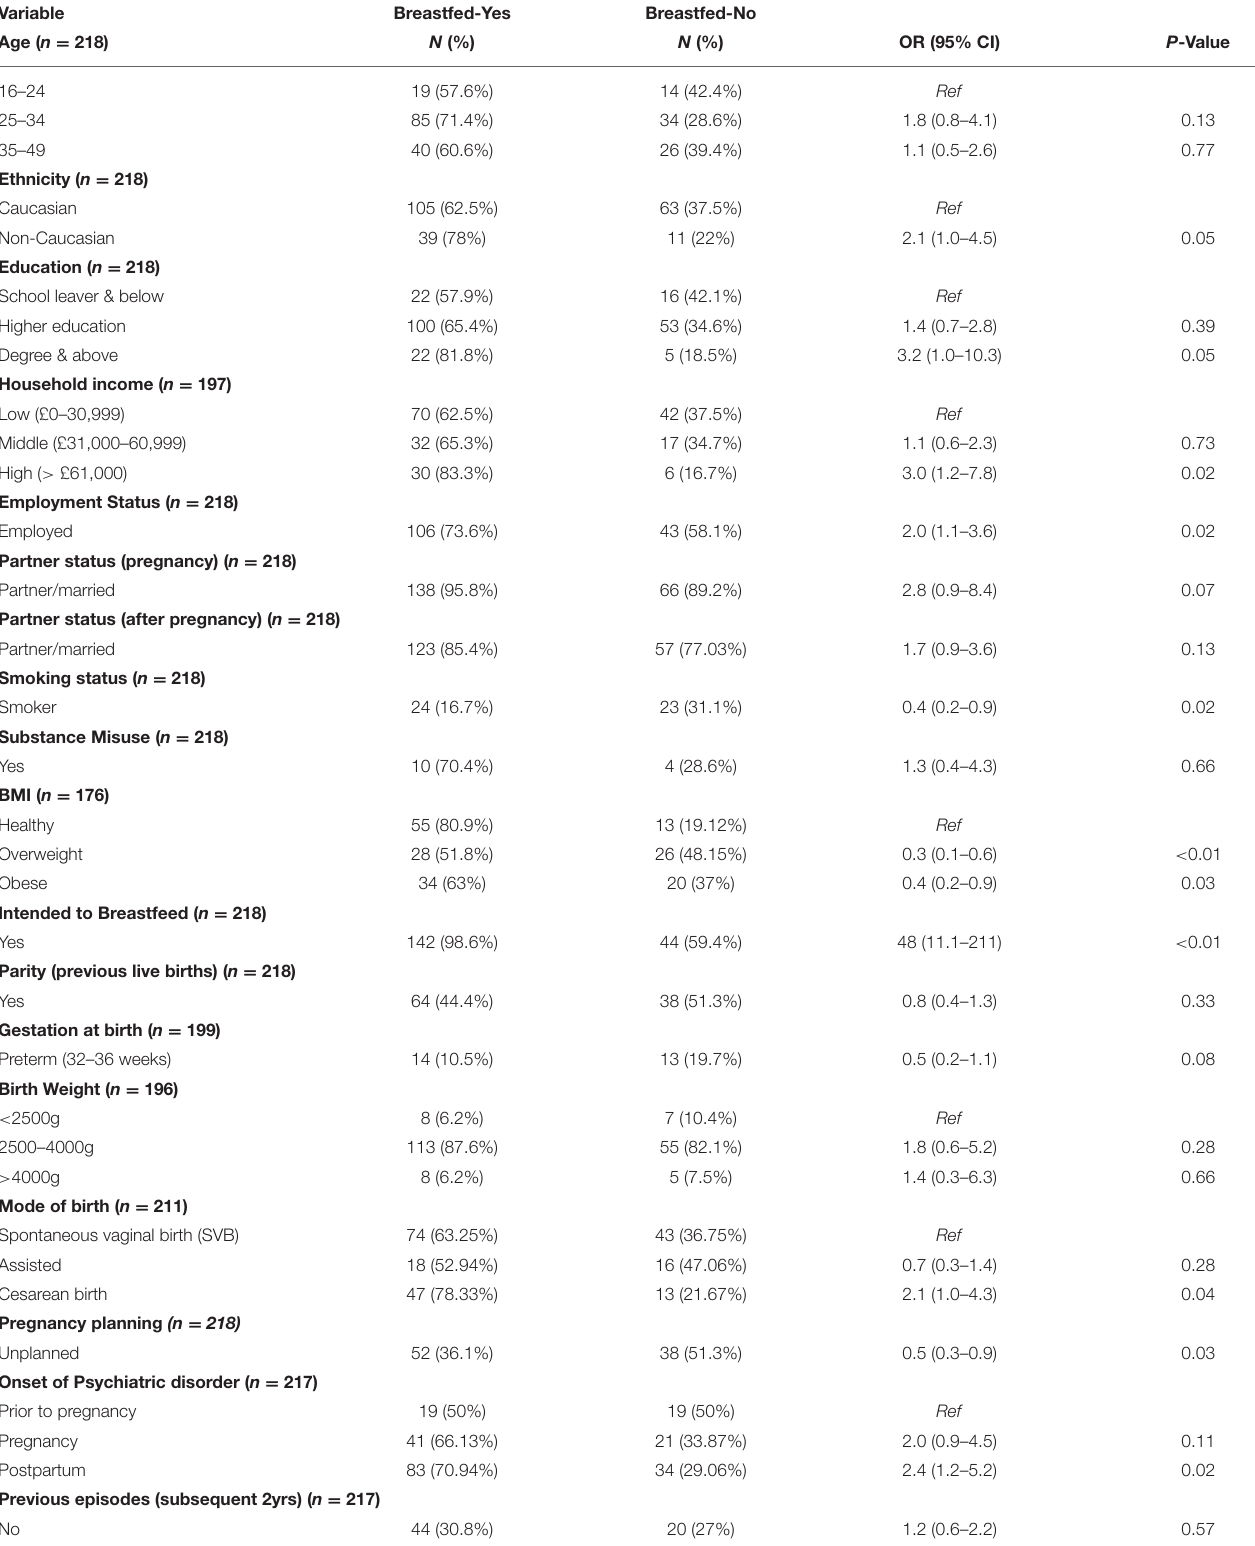
TABLE 1 | Socio demographic and Clinical Characteristics of women who breastfed vs. women who did not breastfeed ( n = 218).